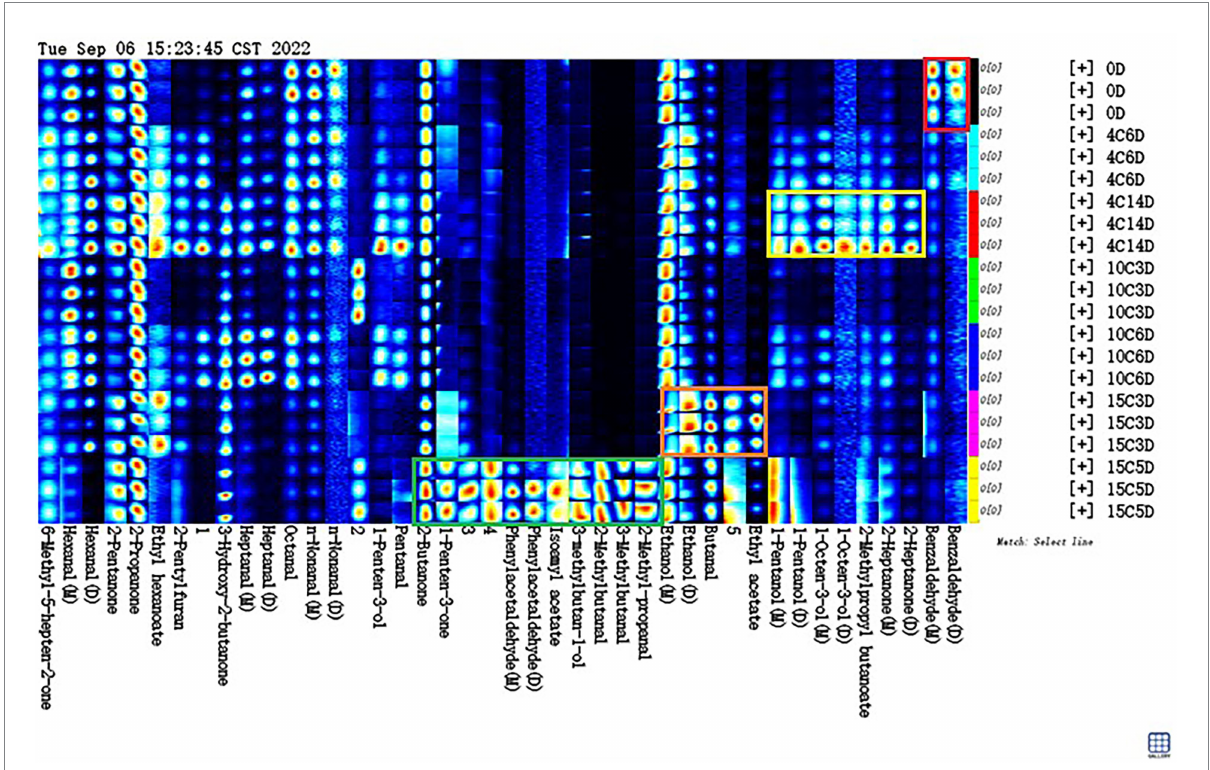
FIGURE 5 Fingerprint spectra of volatile compounds in beef samples different stages aging at 4, 10, and 15 °